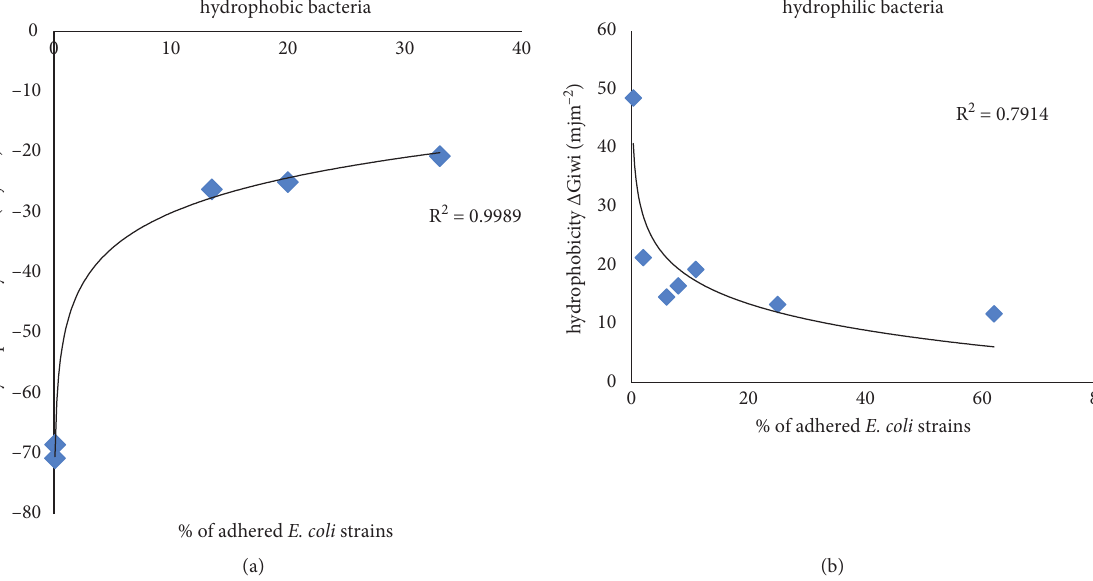
iwi and the percentage of adhered cells of E. coli strains.